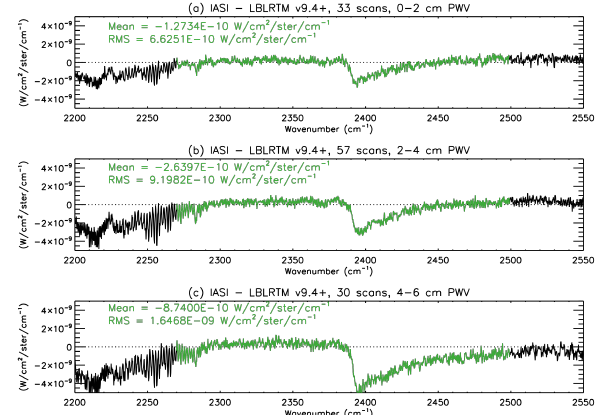
Fig. 11. Mean final (a posteriori) radiance residuals in the CO 2 ν 3 band using LBLRTM v9.4 + as in Fig. 7c, but only for profiles with (a) 0 to 2cm, (b) 2 to 4cm, and (c) 4 to 6cm of precipitable water